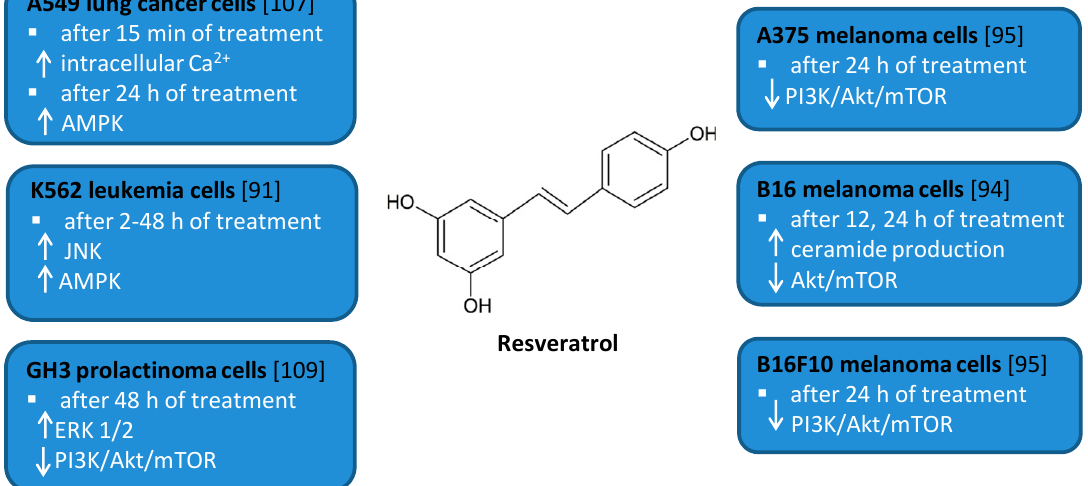
Figure 5. Cell signaling pathways triggered by resveratrol in selected cancer cell lines. ↑ activation/increase; ↓ inhibi- tion/decrease.